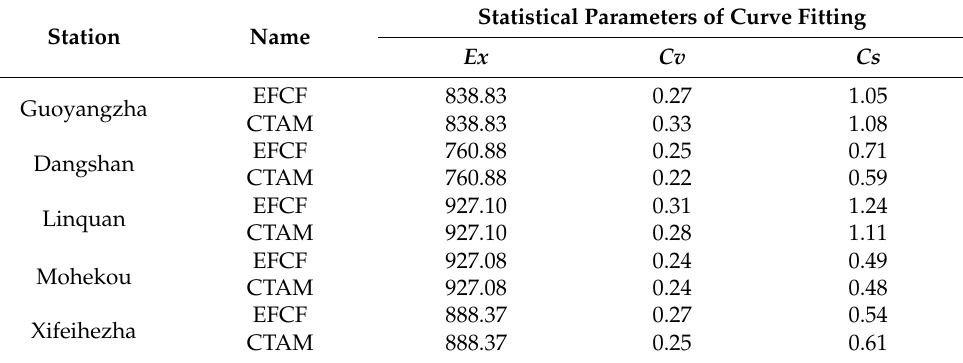
Table 2. Statistical parameters of the annual precipitation frequency curve in northern Anhui province, China.